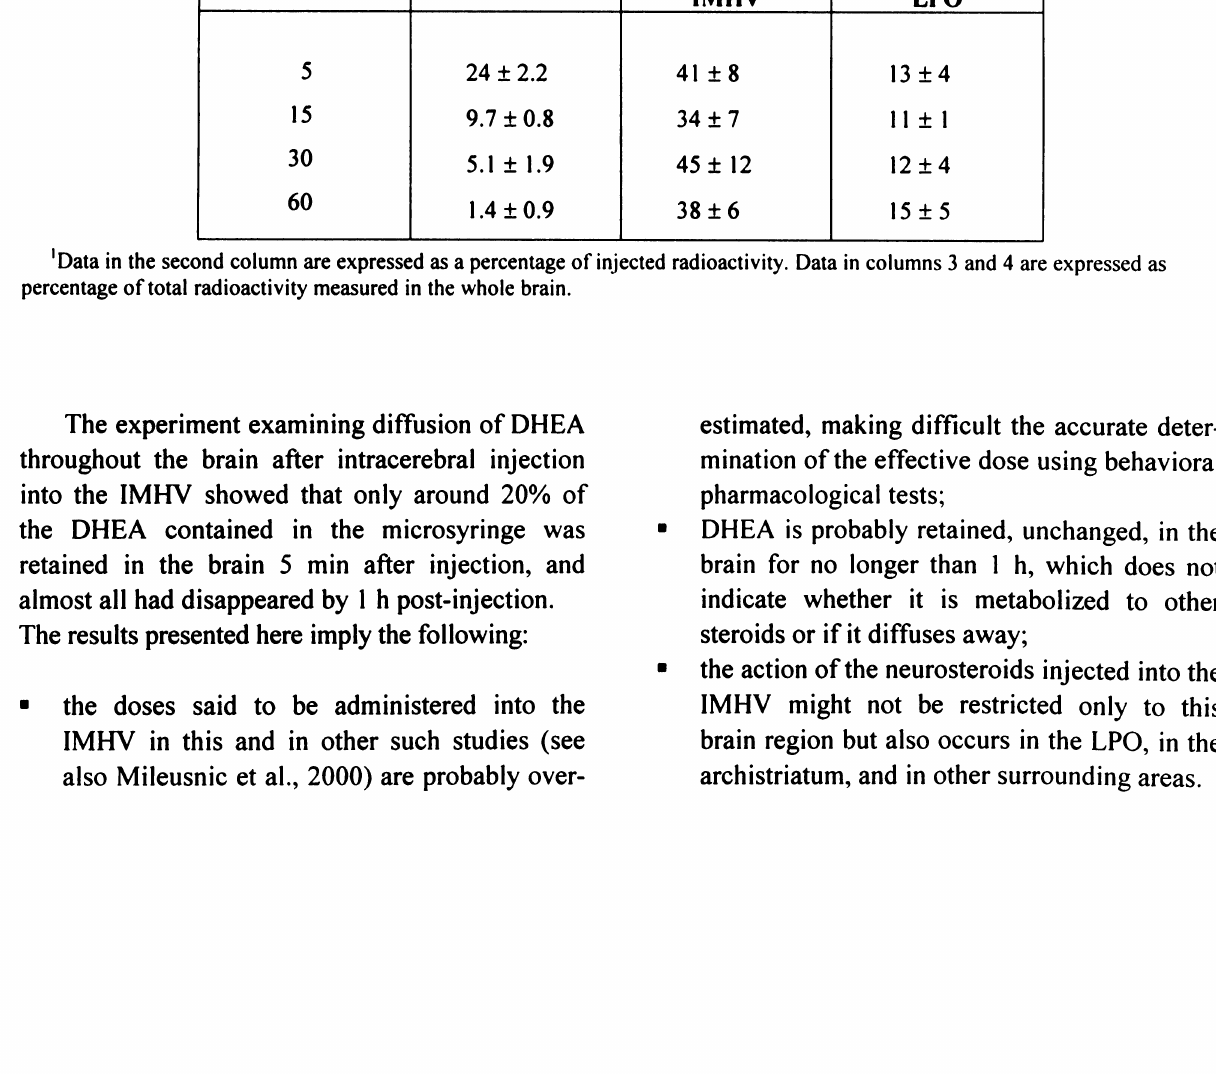
Recovery and distribution of [3H]DHEA in the chick